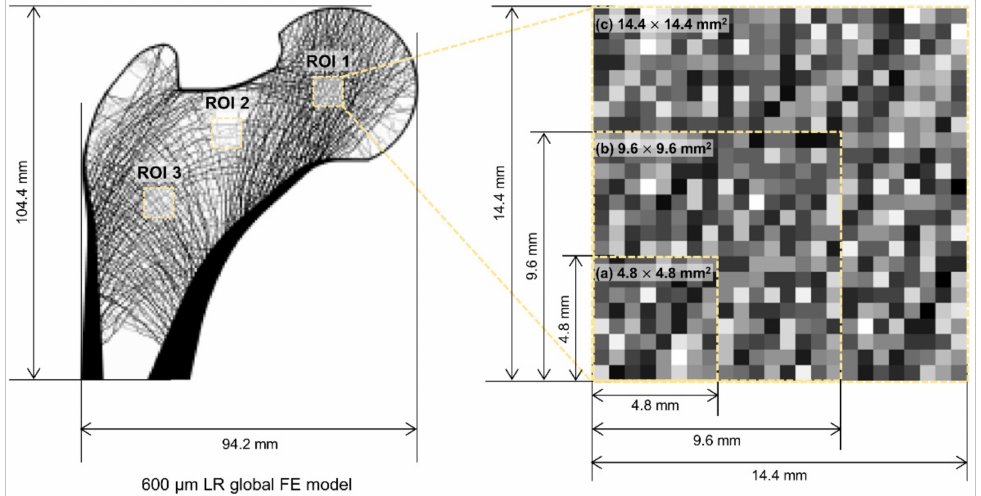
Figure 2. Low-resolution input model of a synthetic proximal femur with three regions of interest: femoral head (ROI 1), femoral neck (ROI 2), and intertrochanteric region (ROI